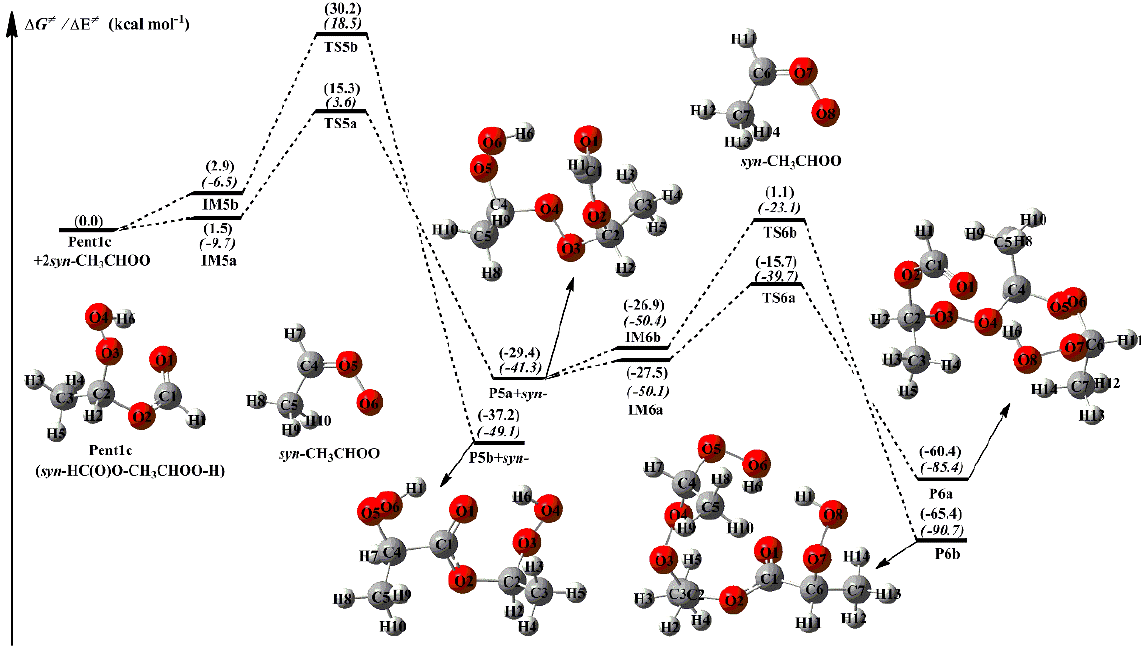
Figure 4. PES ( (cid:49)G and (cid:49)E , in italics) for the 2 syn -CH 3 CHOO + Pent1c reaction at the M06-2X/ma-TZVP//M06-2X/6-311 + G(2df,2p) level of